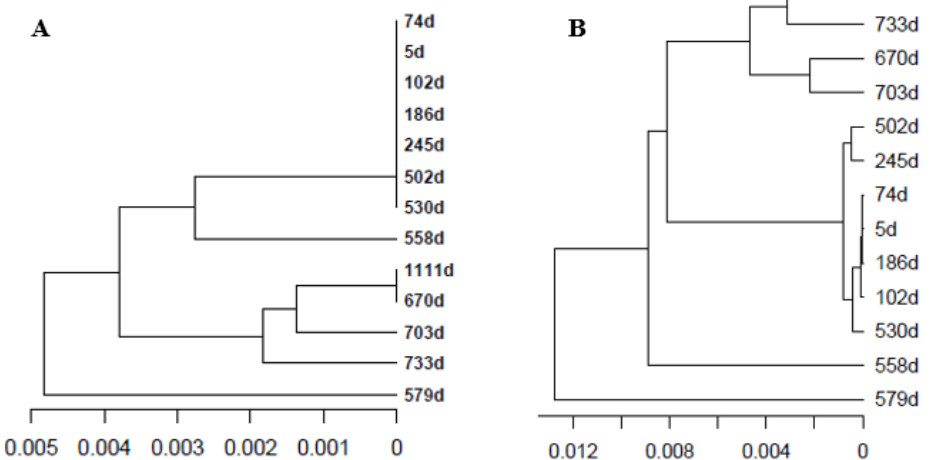
Figure 4. UPGMA tree of the master haplotypes based on raw nucleotide distances ( A ), and quasispecies tree based on the Da population distances ( B ) taking the top 50 haplotypes in each sample. Each sample is labeled as days since the diagnosis.